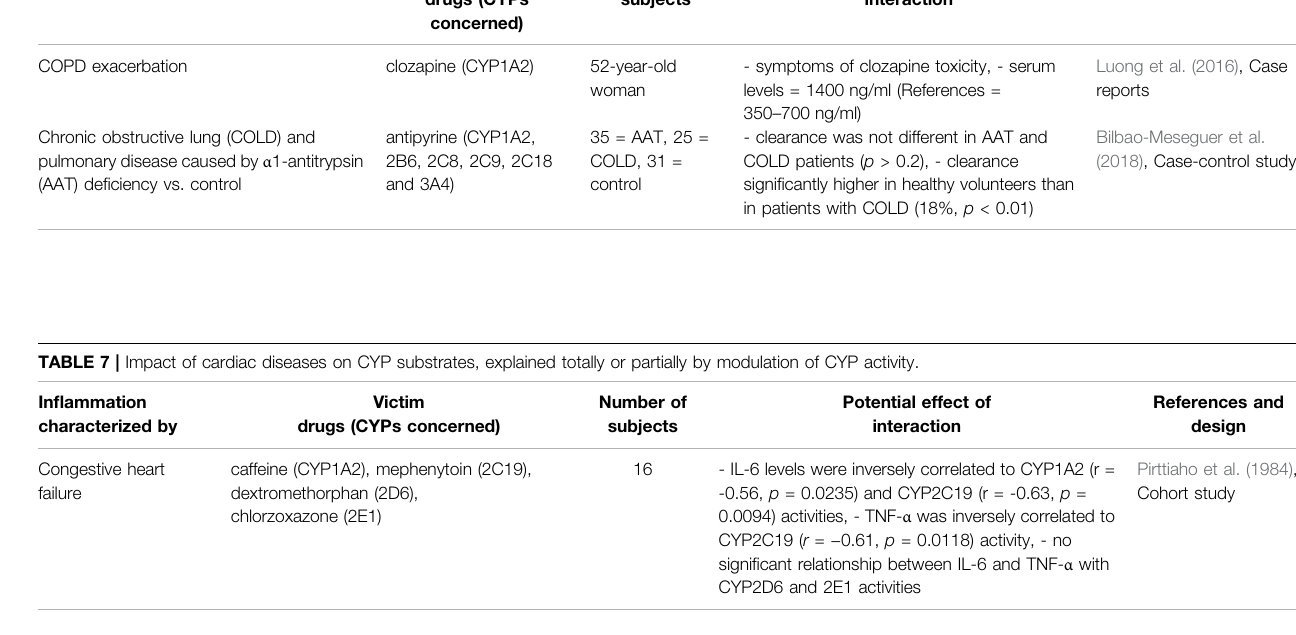
TABLE 6 | Impact of lung diseases on CYP activities. In fl ammation characterized by